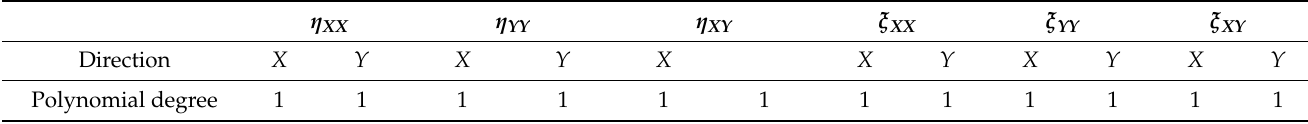
Figure 9: the out of plane line load has been set to 0.01 N , achieving an out-of-plane mm displacement of 12 mm at the plate loaded end in the direct FEM analysis, which is consistent with the assumption of linearity in the displacements both in the direct and inverse FEM. The polynomial pre-extrapolation degrees for this load case are reported in Table 3; the most relevant component to pre-extrapolate to achieve a good displacement reconstruction is ξ XX , i.e., the normalized curvature in the longitudinal direction: the polynomial degree has been set to one, given that for a scenario with constant thickness, the curvature should be linear, as the bending moment. Although all the other pre-extrapolation components have been set to 1, they are actually irrelevant for this load case, but they are reported for the sake of completeness. Table 3. Out-of-plane tip loading: selected polynomial pre-extrapolation